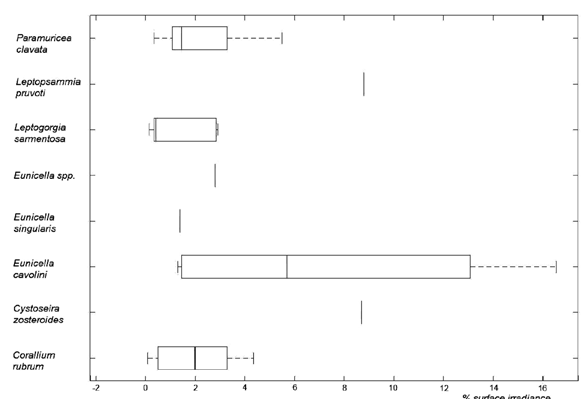
Fig. 5. – Incident light values for the different facies thriving at Portofino